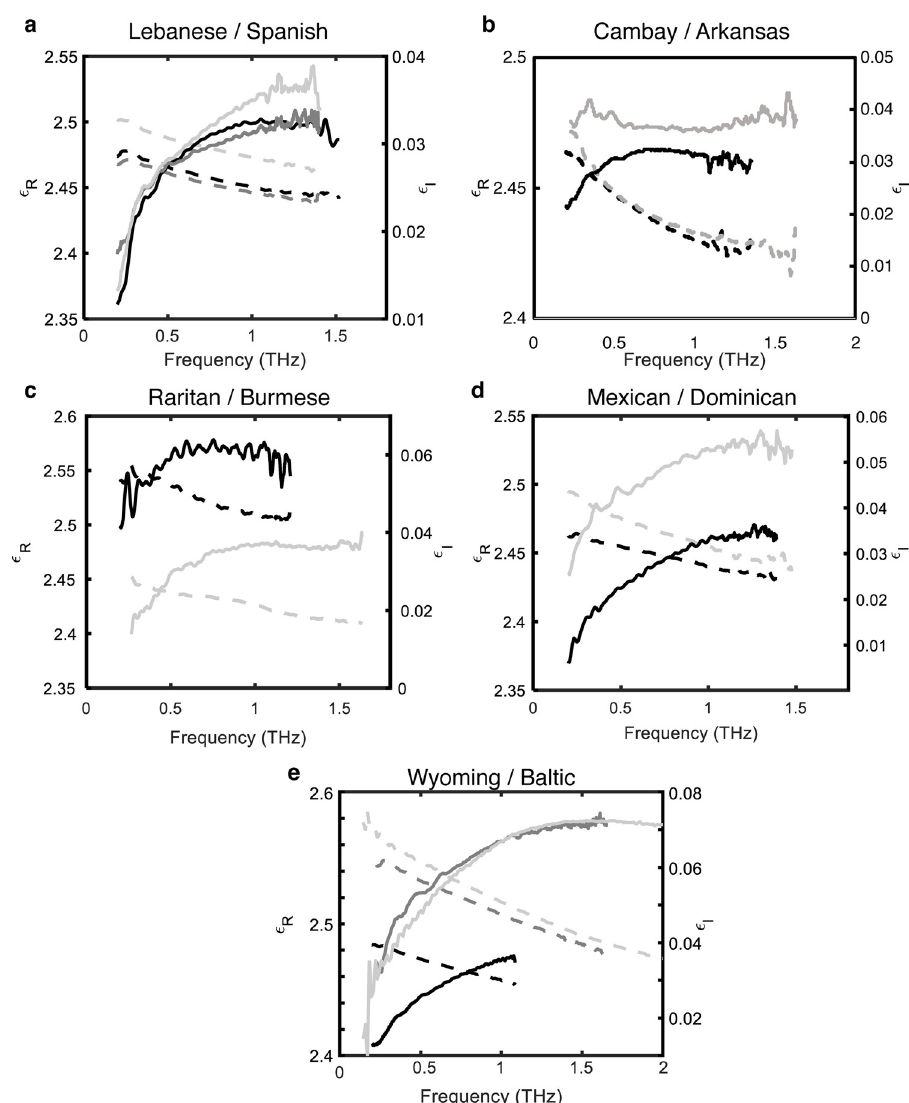
Fig 5. Comparative real and imaginary permittivity of amber localities. Real and imaginary parts of the permittivity are calculated using Eqs (3)–(5). Real permittivity depicted on left axes with dashed lines; imaginary permittivity depicted on right axes with solid lines. (a) Lebanese and Spanish amber: Spectral response for Leb1_C (black lines), Leb1_D (dark gray lines), and Spa1_A (light gray lines) amber samples. (b) Cambay and Arkansas amber: Cam1-C (black) and Ark3-B (gray) dipterocarp samples. (c) Raritan and Burmese amber: NJ1_C (black lines) and BU-0618 (light gray lines) Cretaceous samples. (d) Mexican and Dominican amber: Mex1_B (black lines) and DR1_A (gray lines) amber samples. (e) Wyoming and Baltic amber: WY01_A (black lines) and BA-A (dark gray lines) amber samples. The spectral data of Sasaki et al. Baltic data [28] are shown in light gray.